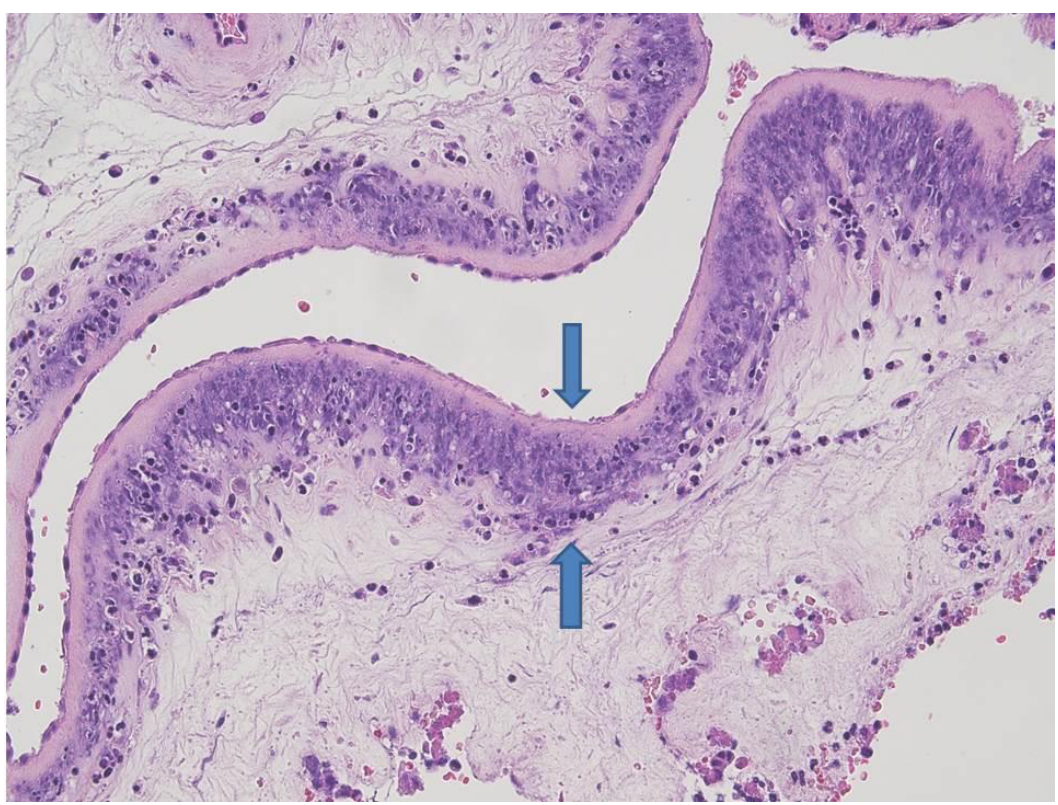
Figure 4. Amniochorial membranes: severe acute chorioamnionitis with focal amnion necrosis (between blue arrows) (HE staining 10 ×